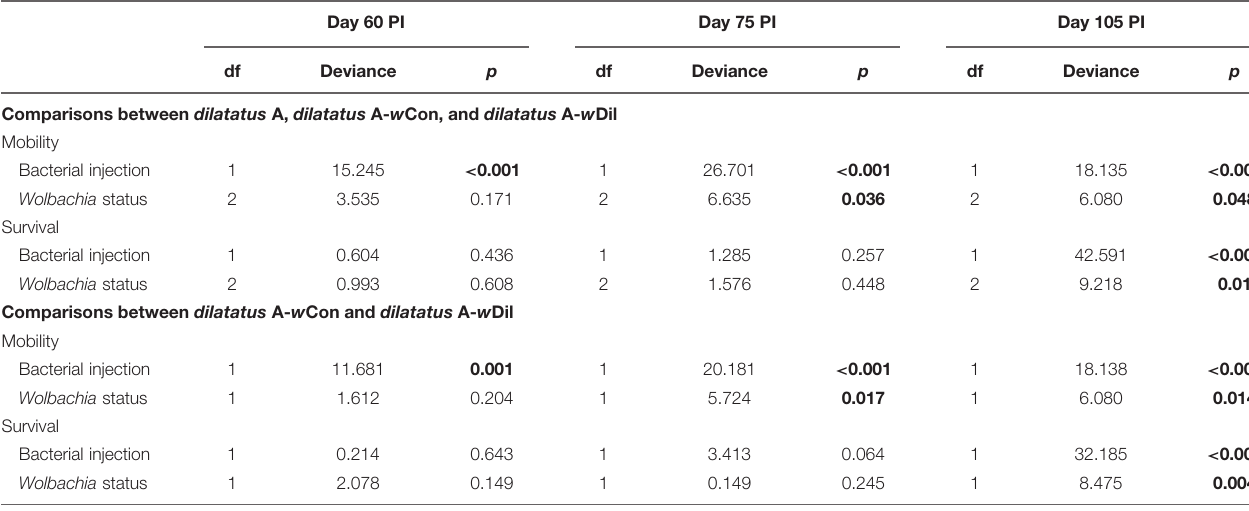
TABLE 3 | Influence of resident Wolbachia on the survival and mobility of P. dilatatus infected with w VulC. Day 60 PI Day 75 PI Day 105 PI df Deviance p df Deviance p df Deviance